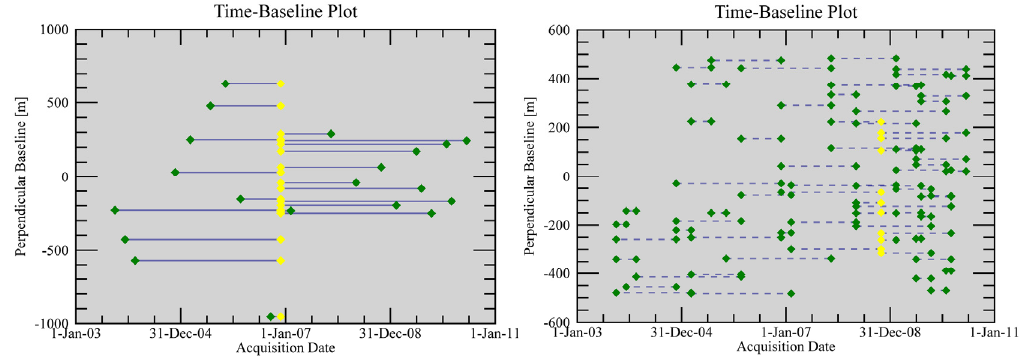
Figure 2. Perpendicular baseline variations for both PS and SBAS ‐ InSAR interferograms. Green diamonds represent selected interferogram pairs, and the yellow diamonds represent the selected master image of PS (left side: 28 November 2006) and SBAS (right side: 28 October 2008). PS: Persistent Scatterer; SBAS ‐ InSAR: Small Baseline Subset ‐ Interferometric Synthetic Aperture Radar.